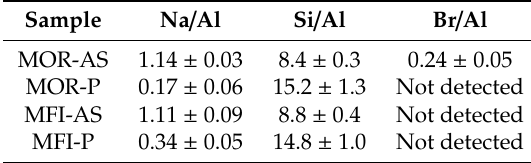
Table 1. EDX elemental analysis of the as synthetized and pillared samples.